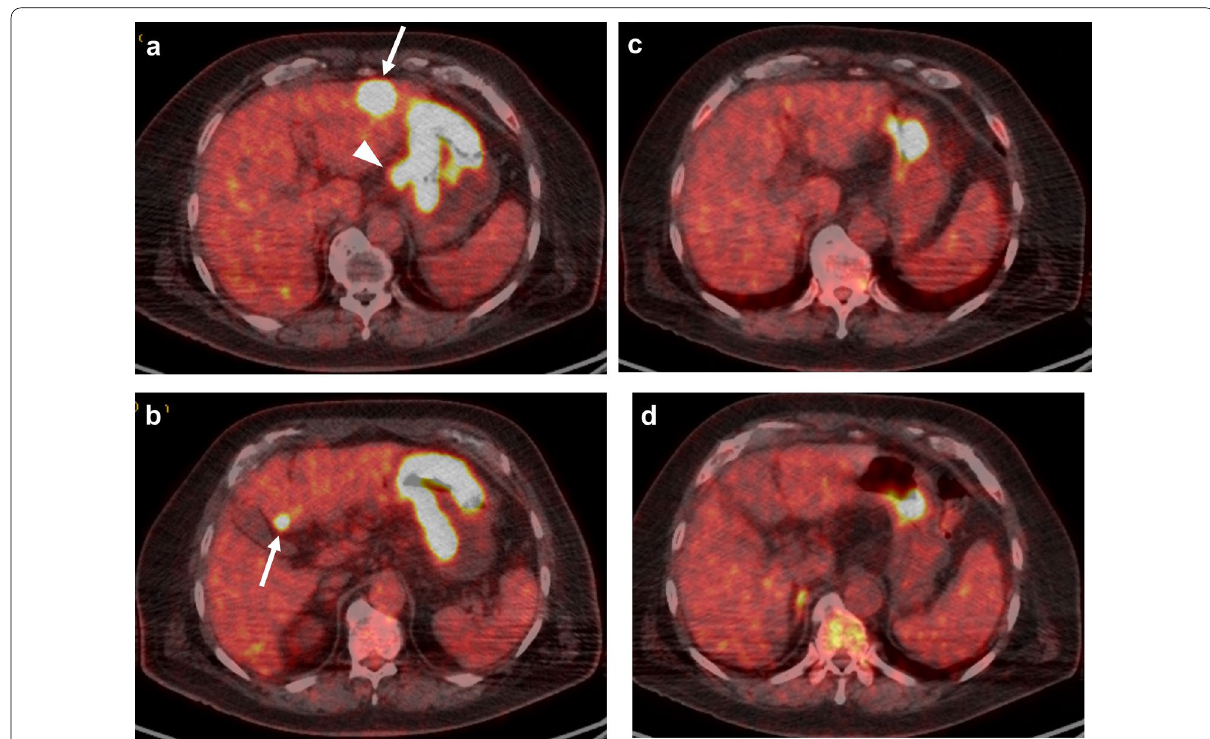
Fig. 3 Positron emission tomography–computed tomography. a , b Before chemotherapy. Abnormal uptake in the primary tumor, enlarged station 3 lymph nodes (arrowhead), and tumors in the segments 3 and 4 of the liver (arrows) are seen. c , d After six courses of ramucirumab plus paclitaxel, the abnormal uptake in the lymph node and liver metastases